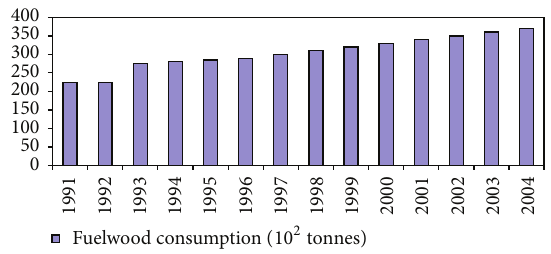
Figure 2: Fuelwood consumption from 1991 to 2004 [9].